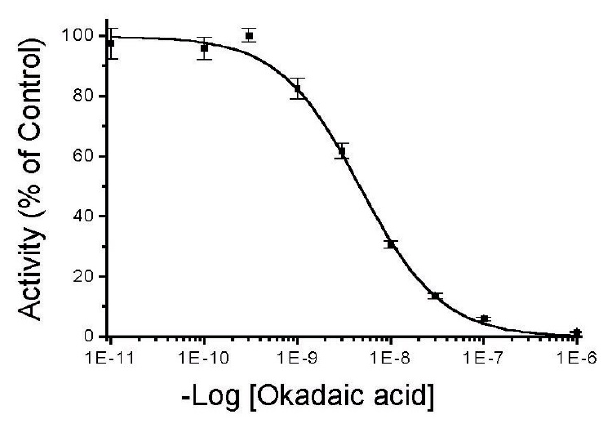
Figure 1 Inhibition of PP5 by okadaic acid. The purified catalytic subunit of PP5 was assayed, using [ 32 P]labeled phosphohis- tone as a substrate as described in Materials and Methods. The data is expressed as % of controls, with control activity being 4.2 ± 0.25 µ mole/min/mg protein. Okadaic acid was mixed with the enzymes for 10 min at 23 ° C prior to the initi- ation of the reaction with the addition of substrate. Inhibition assays contained ~ 200 pM PP5. The data represent the mean SD (n =